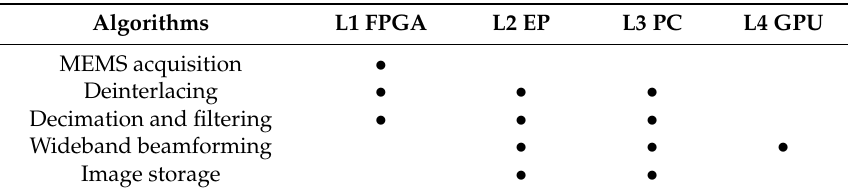
Table 1. Algorithms vs. processing level.